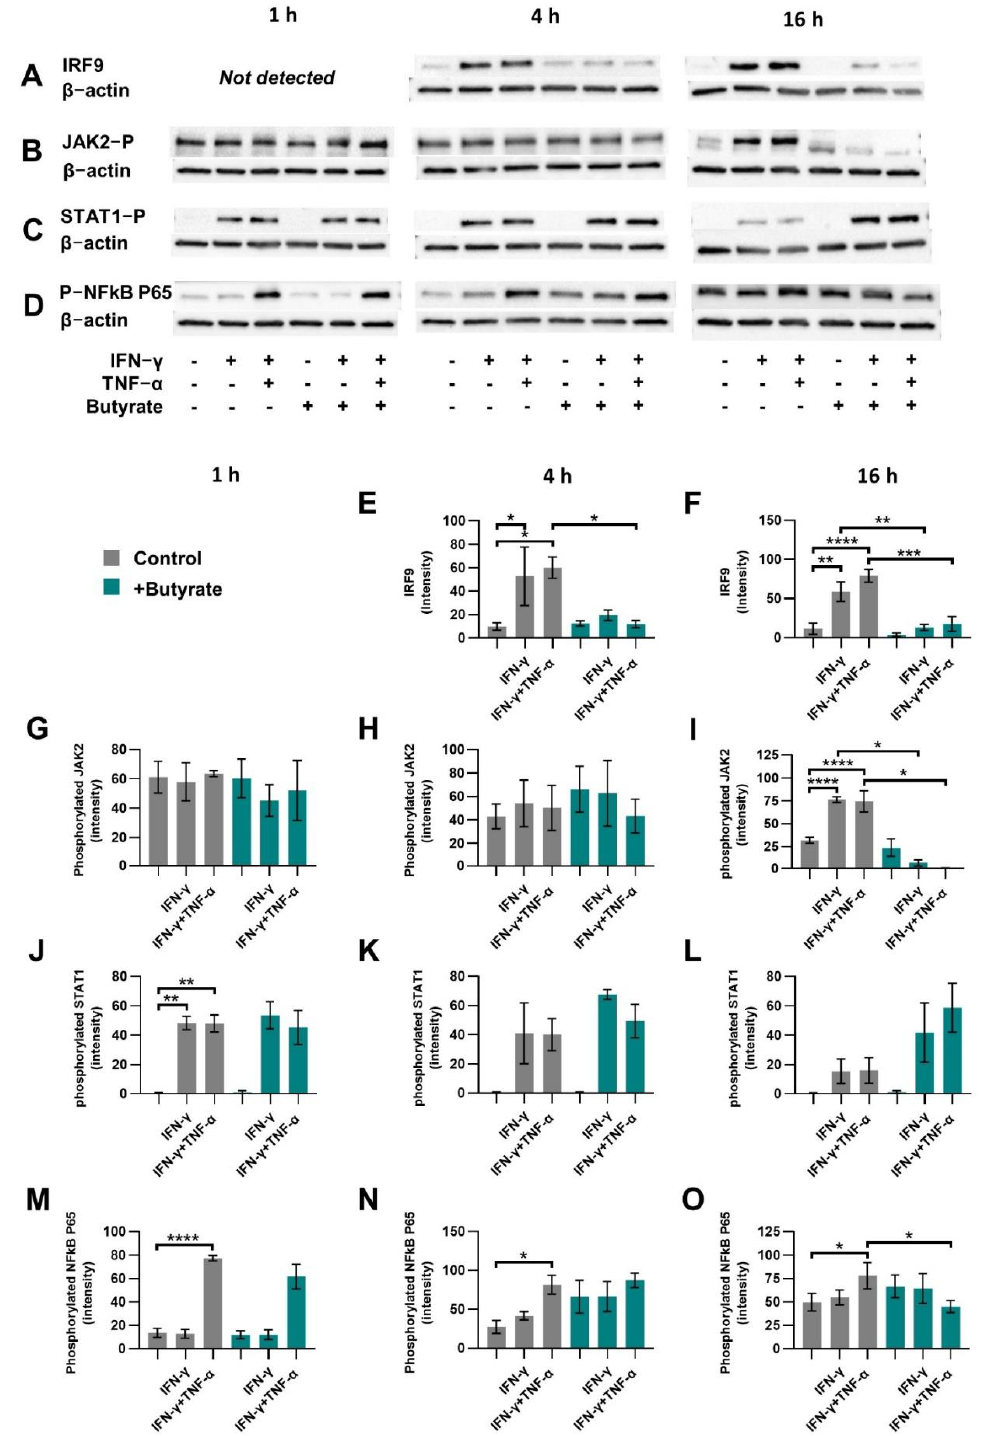
Figure 3. Canonical or non-canonical STAT1 pathway protein expression. Cells were activated with IFN- γ or IFN- γ +TNF- α and treated with 2 mM butyrate (green bars) for 1 h, 4 h or 16 h. IRF9 ( A , E , F ), phosphorylated JAK2 ( B , G – I ), phosphorylated STAT1 ( C , J – L ) and phosphorylated NFkB p65 ( D , M – O ) protein expression was determined. Representable blots of proteins of interest and β -actin control are shown in A-D. Data are represented as mean ± SEM ( n = 3). Significant differences are shown as * p < 0.05, ** p < 0.01, *** p < 0.001, **** p < 0.001, medium control as compared to 2 mM butyrate control or to IFN- γ or IFN- γ +TNF- α -activated intestinal epithelial cells in absence of butyrate. Activated cells were also compared to activated cells treated with